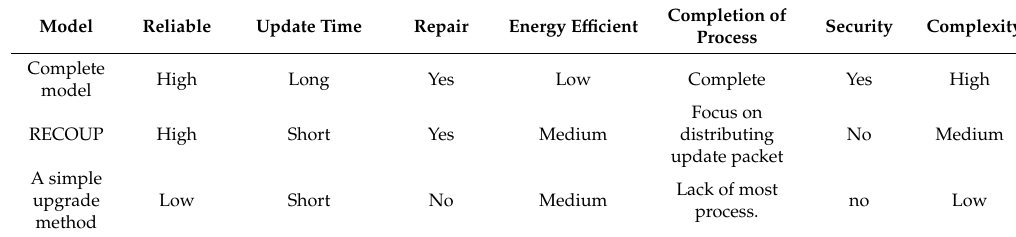
Table 5. Overview of existing approaches in major